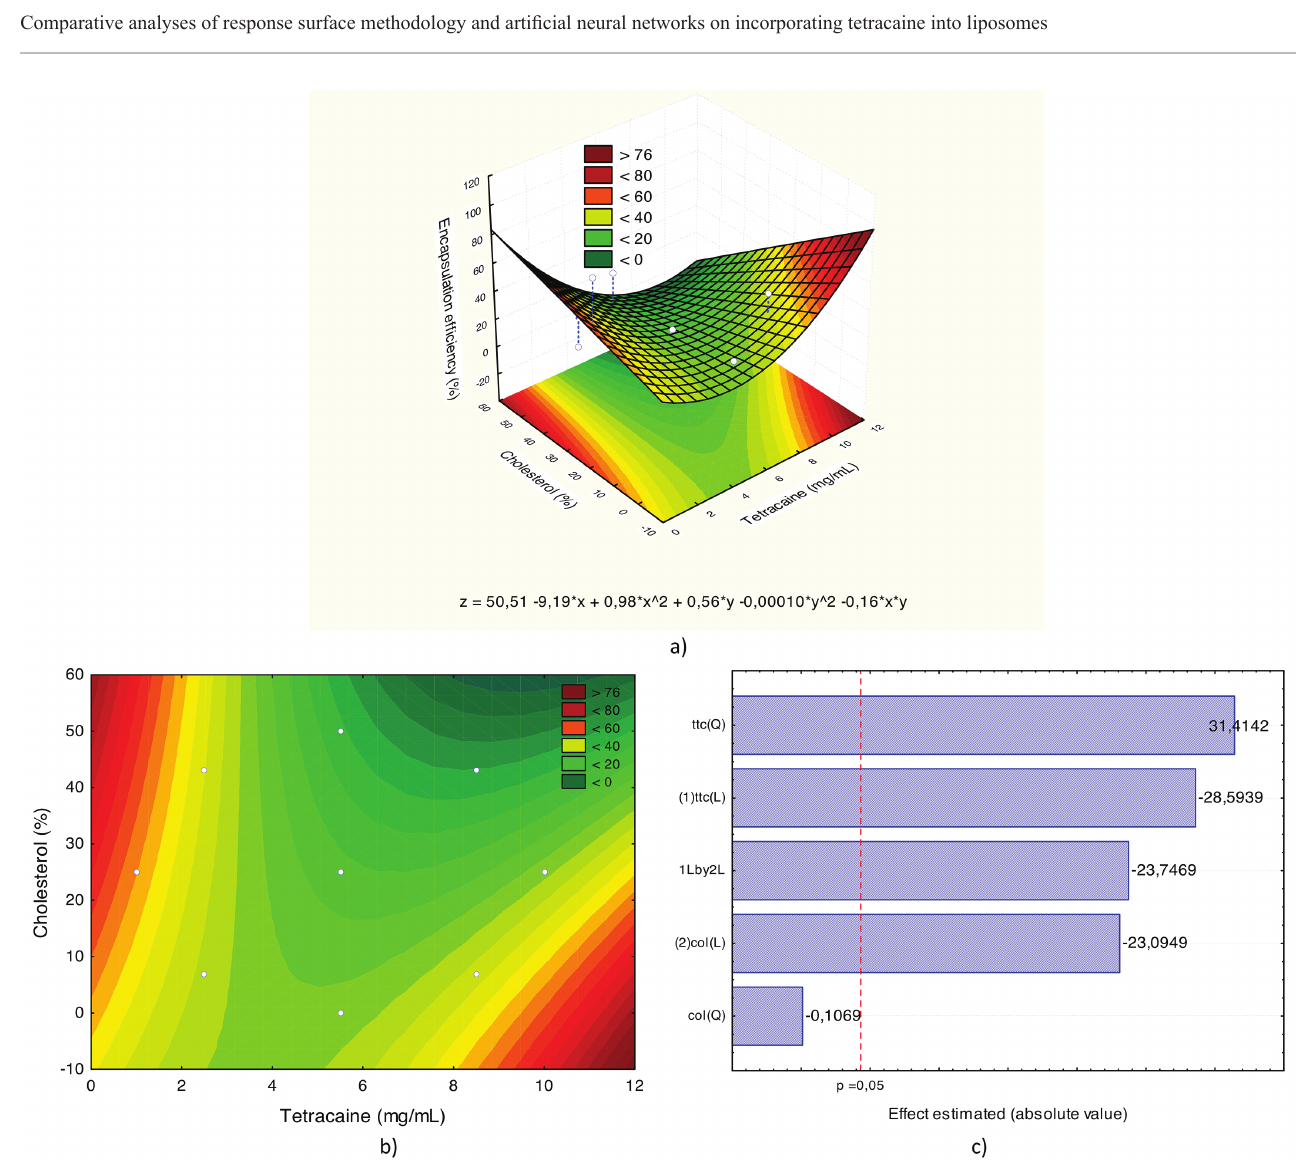
FIGURE 5 - Response surface (A), contour curve (B) and Pareto chart (C) for the encapsulation efficiency of liposomes prepared in the lipophilic